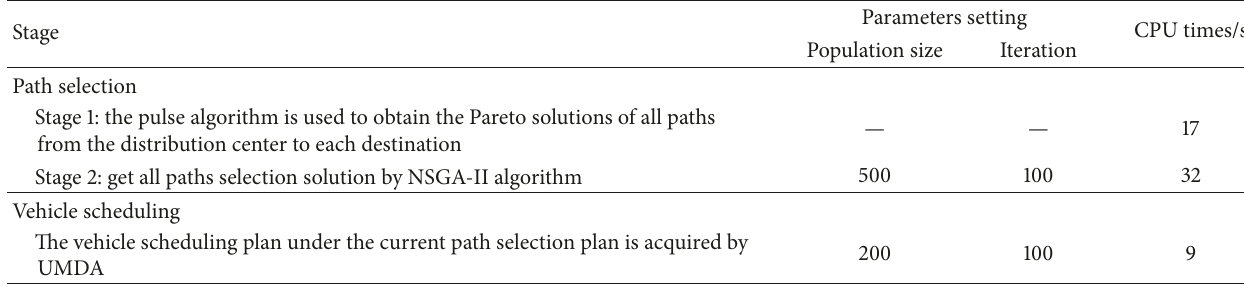
Table 8: Transport parameters setting in the program and CPU